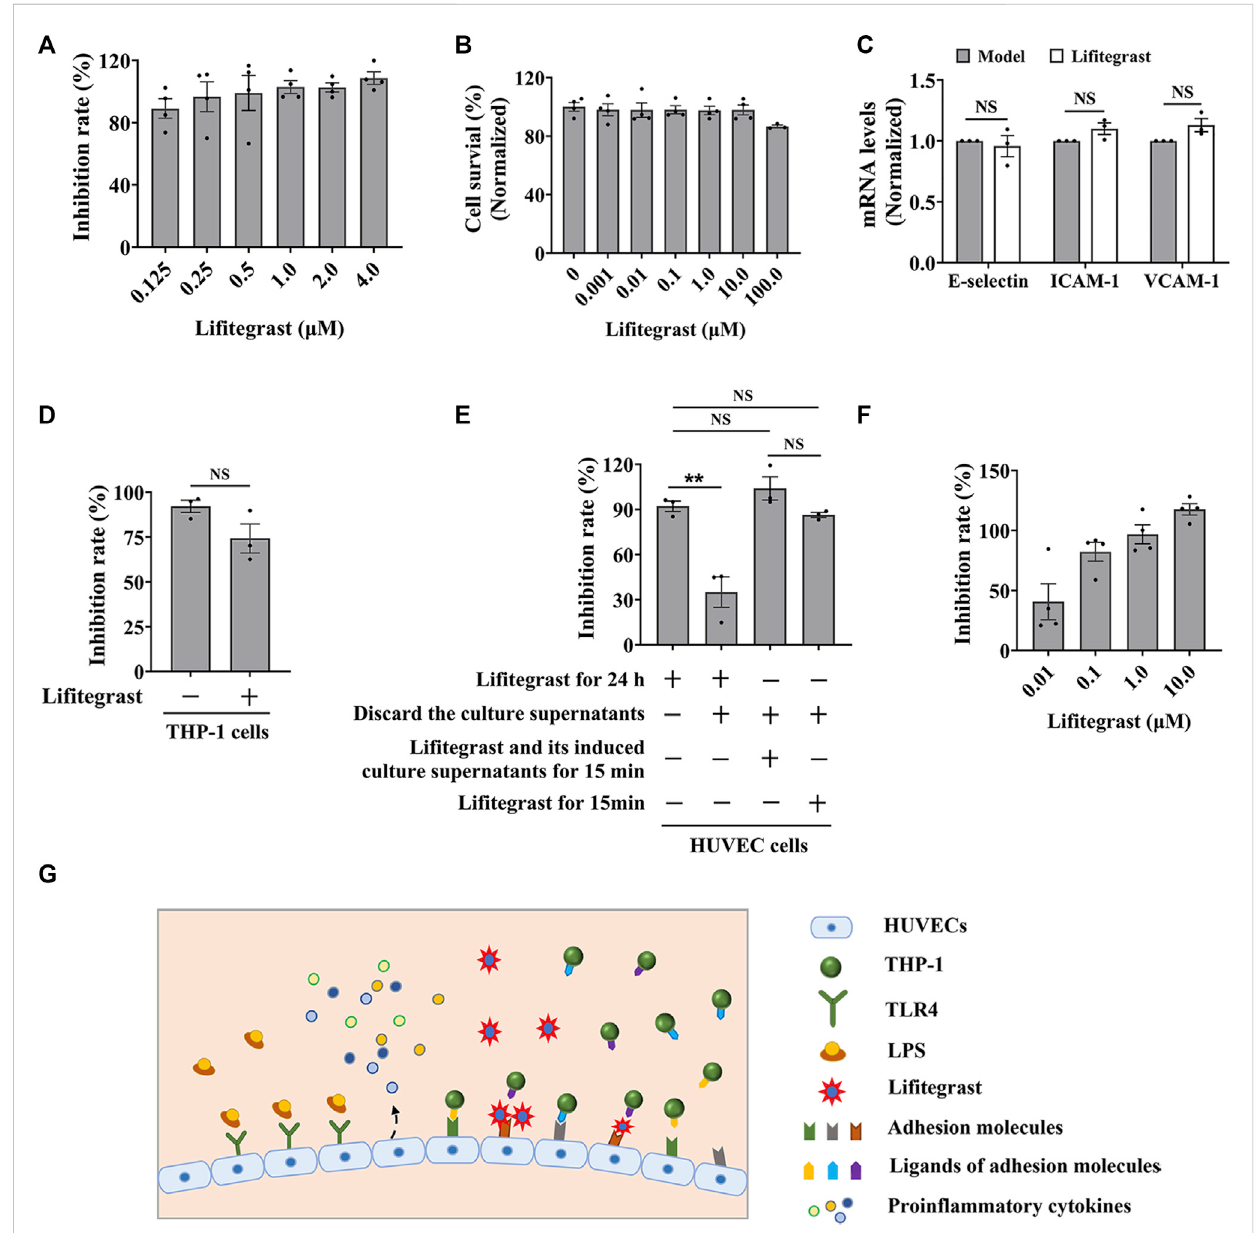
FIGURE 3 Li fi tegrastdirectlyinterruptstheadhesioninteractionbetweenHUVECandTHP-1cells. (A) Theinhibitoryactivityofli fi tegrastagainstcelladhesionin the standardized model. (B) The cytotoxicity of li fi tegrast to HUVEC cells for 24 h. (C) The mRNA levels of adhesion molecules in HUVEC cells treated by LPSandli fi tegrastfor24 h. (D) Inthestandardizedmodel,theTHP-1cellsweretreatedadditionallywithli fi tegrastfor24 h. (E) HUVECcellsweretreatedat differentstagesof cell adhesion, such as adding li fi tegrast together with LPS for 24 h, or discarding the culture supernatantsof LPS and li fi tegrast, or replacing the culture supernatants of LPS with that of li fi tegrast, or with fresh culture medium containing li fi tegrast, and then co-cultured with labeled THP-1cellsfor15 min. (F) HUVECcellsweretreatedbyLPSfor24 h,theculturesupernatantswerereplacedwithculturemediacontainingli fi tegrast,and then co-cultured with labeled THP-1 cells for 15 min. (G) The diagram of li fi tegrast against cell adhesion. Data were presented as mean ± SEM over three experiments. NS: no signi fi cance, ** p < 0.01 vs. the group of retained culture